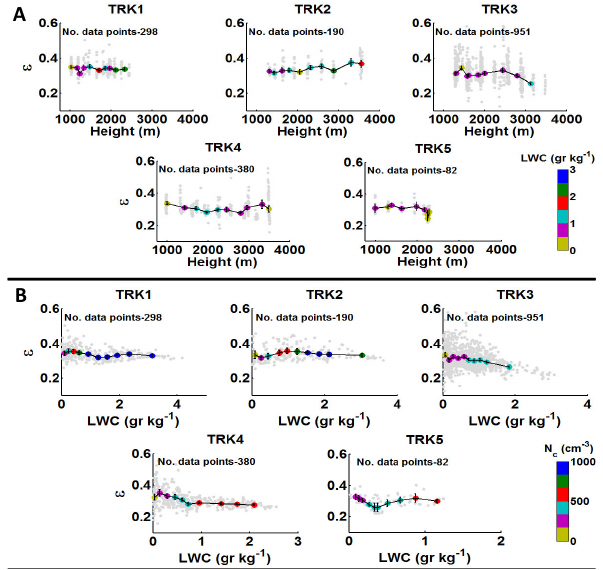
Figure 3. (a) Relative dispersion ( ε ) vs. height above the ground with colors representing the liquid water content (LWC) and (b) ε vs. LWC with colors representing the droplet concentration for the inner cloud data points. Error bars represent standard error of the average ε for each height level (in a ) and LWC (in b ) with a confidence level of